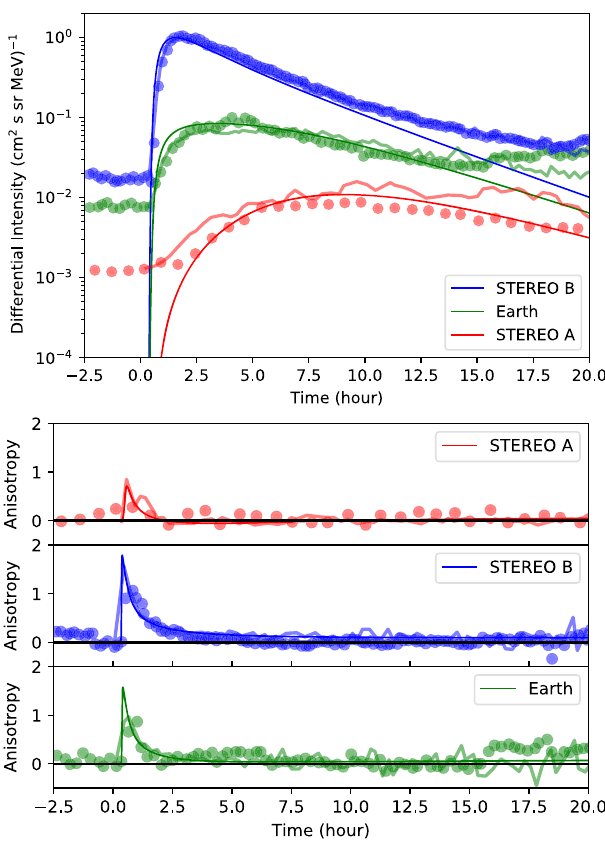
Fig. A.1. The top panel shows a comparison between STEREO A (red), STEREO B (blue), and ACE (Earth, green) observations (data points), modelling solutions from a 3D stochastic differential equation (SDE, thick curves) model, and a 2D model employing a fi nite difference (FD, thin lines) approach. The top panel compares the differential intensity and the bottom panel the resulting particle